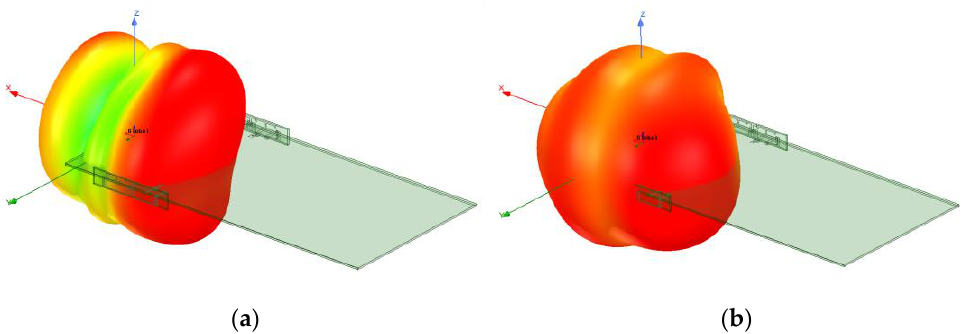
( b ) XOZ plane. Figure 14. Measured radiation patterns of the proposed antenna at 3.5 GHz in ( a ) XOY plane and